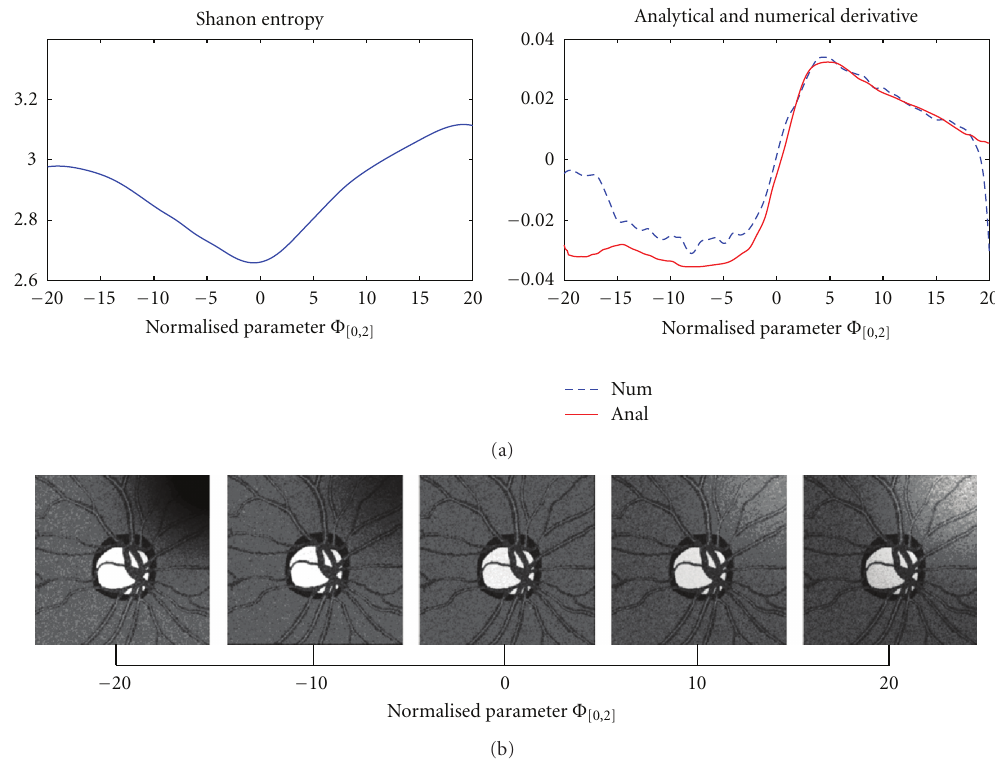
Figure 5: (a): Shannon entropy-based criterion and its partial derivative as functions of the parameter Φ [0,2] (control point in upper-left image corner) (b): Examples of influence of Φ [0,2] varying from 20 to 20 with step 10, which primarily influences the upper right corner correction; notice the optimum illumination correction for the value of Φ [0,2] corresponding to the zero derivative position